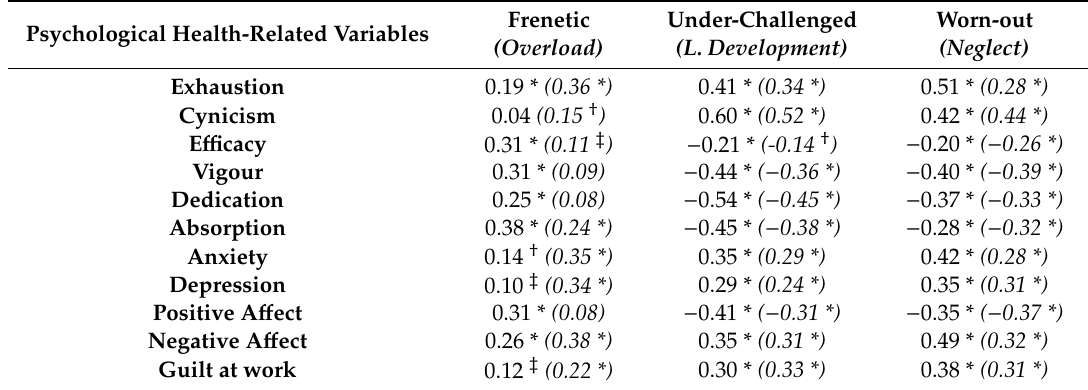
Table 6. Raw correlations between the BCSQ and other psychological health-related variables. Psychological Health-Related Variables